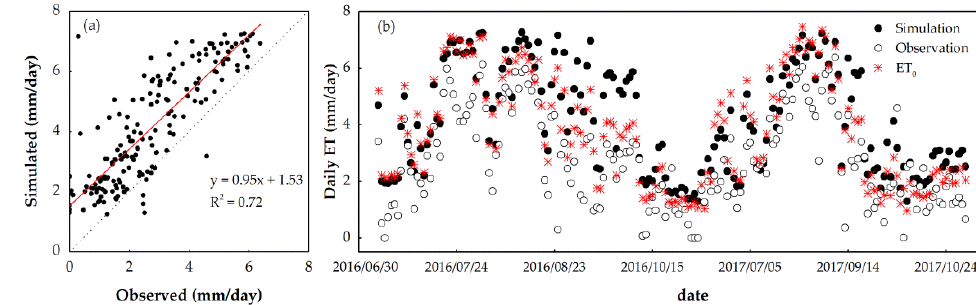
Figure 4. Comparisons between model simulated with observed daily evapotranspiration (ET)